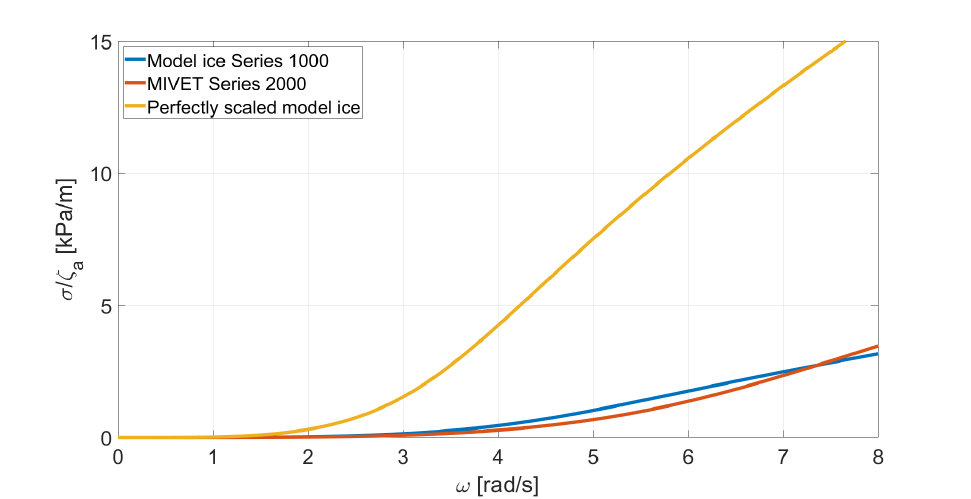
Figure 11. Stress RAO for the two tested ice sheets and a model ice with properties perfectly in